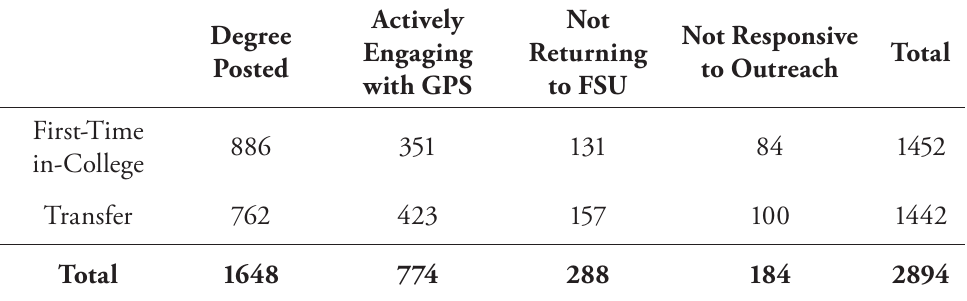
Actively Not Degree Not Responsive Engaging Returning Posted to Outreach with GPS to FSU